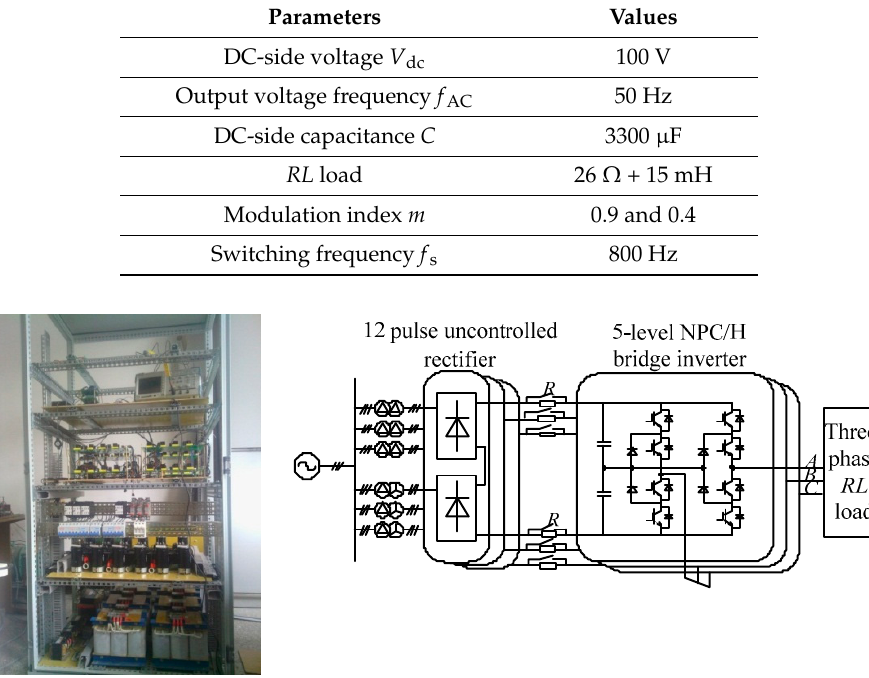
Figure 10. The experimental platform.